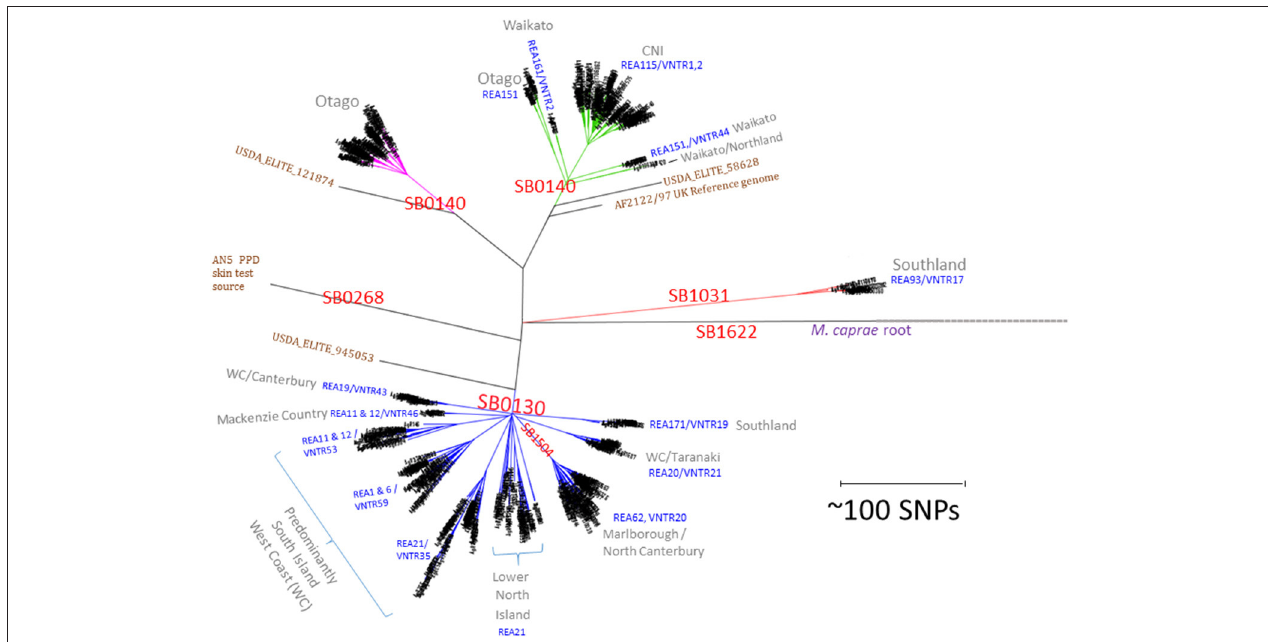
FIGURE 1 | NZ M. bovis types. Radial Maximum Likelihood (ML) Phylogram illustrating the relationship of NZ M. bovis isolates in the NZ WGS database. The scale bar indicates the approximate distance in SNPs between isolates. “SB” numbers labeled in red are internationally recognized spoligotypes based on differences in the DR/CRISPR region. The REA and VNTR types listed in blue text are the predominant REA type(s) and or VNTR types in the indicated cluster and they are predominant in regions listed in gray. Overseas isolates that are included for comparison are labeled in brown: the UK reference (AF2122/97), the UK strain commonly used as a